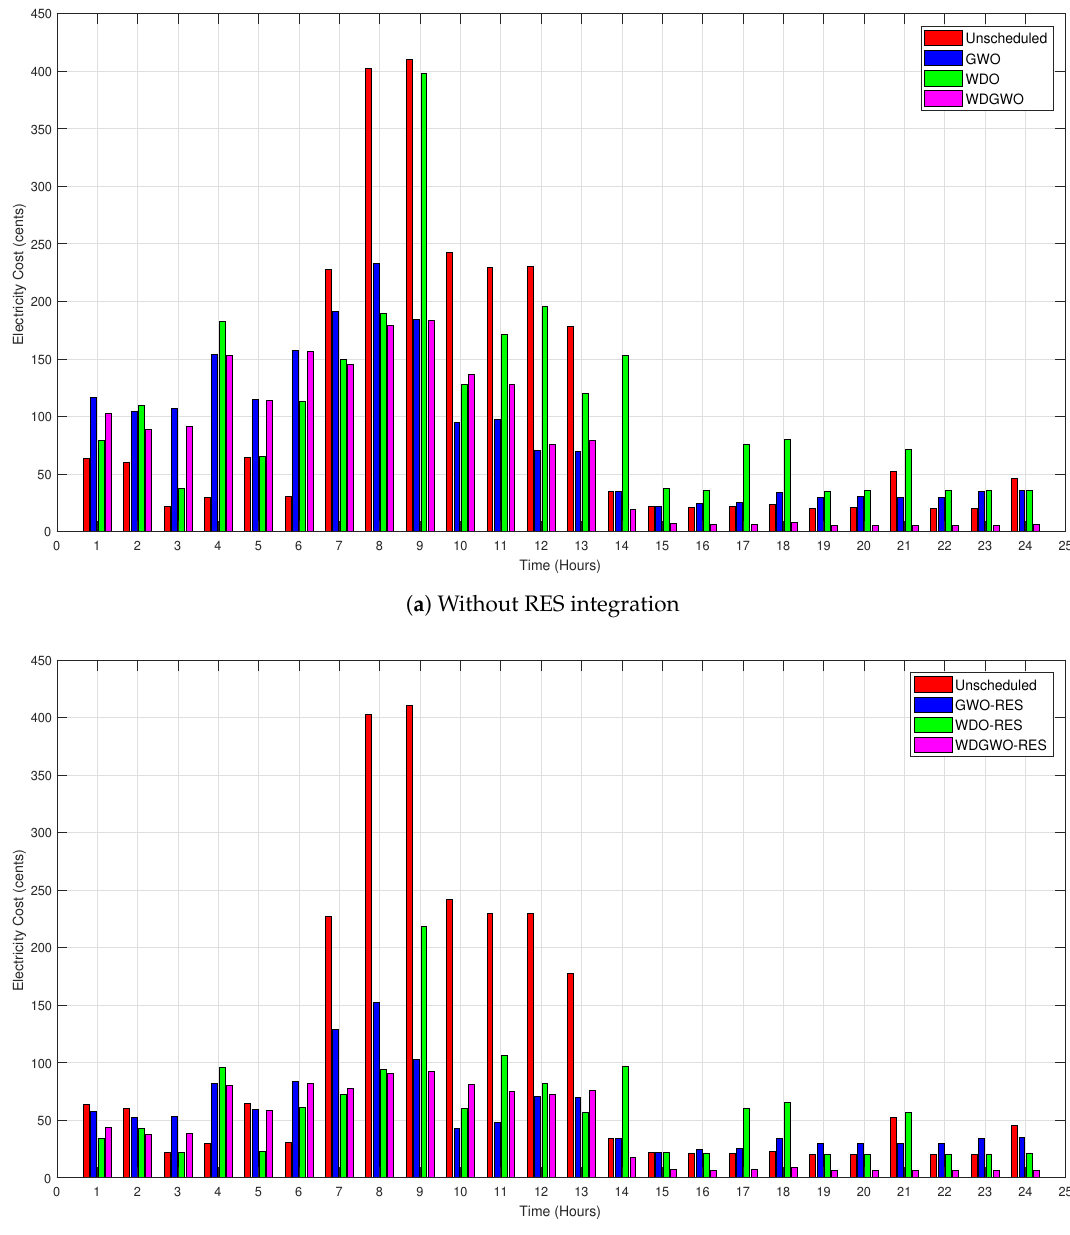
Figure 8. Electricity cost of